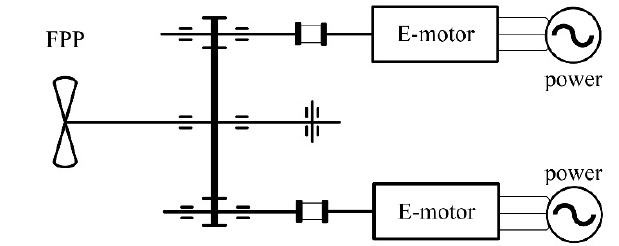
Figure 1. Schematic diagram of two engines and one shaft propulsion system.